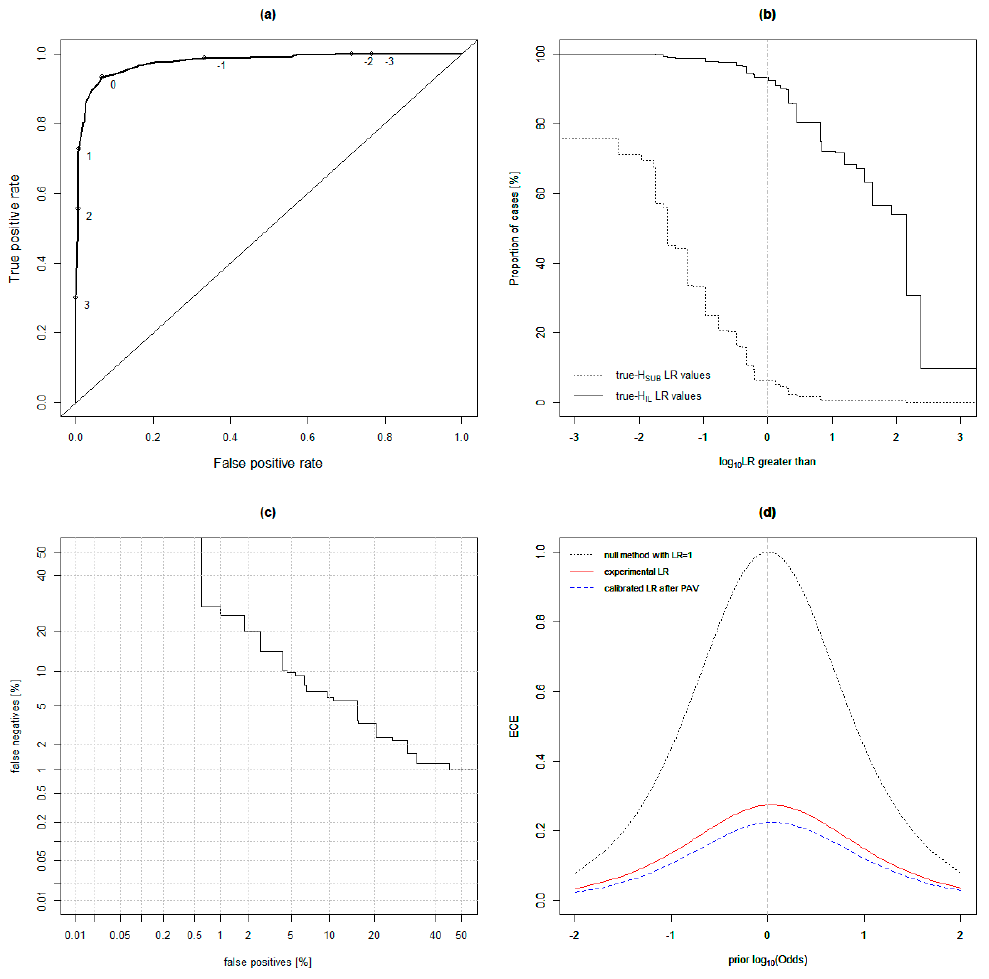
Figure 4. Plots showing the performance of a model based on distribution A from Table 1 and the assumption of different covariance matrices for the IL and SUB classes (i.e., QDA model) using Equation (1). Plots include: ( a ) the ROC plot with LLR cutoff points labeled, ( b ) the Tippett plot, ( c ) the detection error trade-off (DET) plot and ( d ) the empirical cross-entropy (ECE) plot.